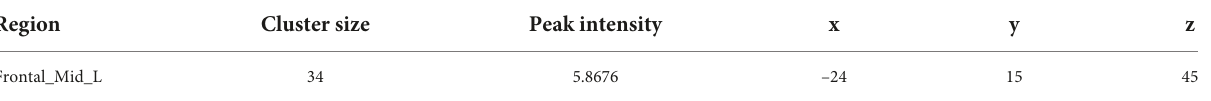
TABLE 3 Brain region with a significant difference in zfALFF between two groups. Region Cluster size Peak intensity x